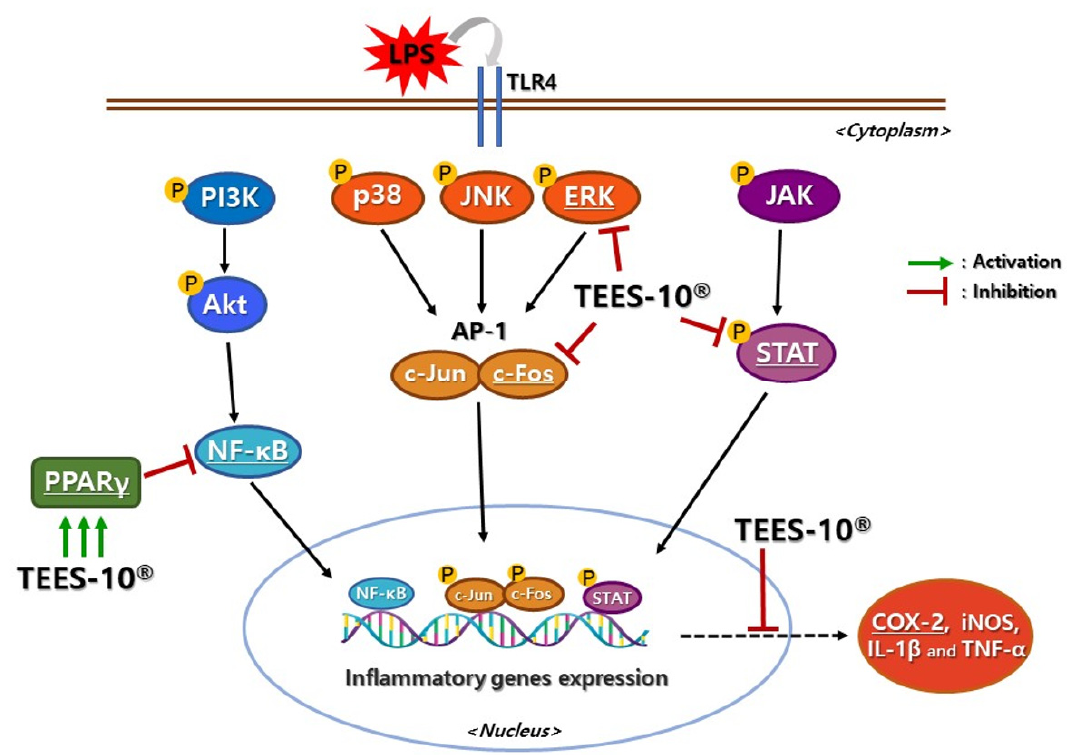
Figure 6. The schematic diagram showing the proposed mechanism of anti-inflammatory effects of TEES-10 ® in the LPS-induced PDL cell. TEES-10 ® inhibits production of inflammatory mediators such as NF- κ B, p-ERK, c-Fos, p-STAT that mediate inflammatory genes expression in nucleus and TEES-10 ® decreases COX-2 which is inflammation reaction products. In addition, TEES-10 ® activates expression of anti-inflammatory mediators such as PPAR γ which function inhibition of NF- κ B activation. Therefore, TEES-10 ® could resolute LPS induced inflammation. LPS: Lipopolysaccharide, TLR: Toll-like receptor, PI3K: Phosphatidylinositol-3-phosphate kinase, AKT: Protein kinase B, NF: Nuclear factor, JNK: c-Jun N-terminal kinase, PPAR: Peroxisome-proliferator-activated receptor, ERK: extracellular signal-regulated kinase, AP: Activator protein, JAK: Janus kinase, STAT: signal transducer and activator of transcription, COX: cyclooxygenase, iNOS: inducible nitric oxide synthase, IL: interleukin, TNF: tumor necrosis factor.